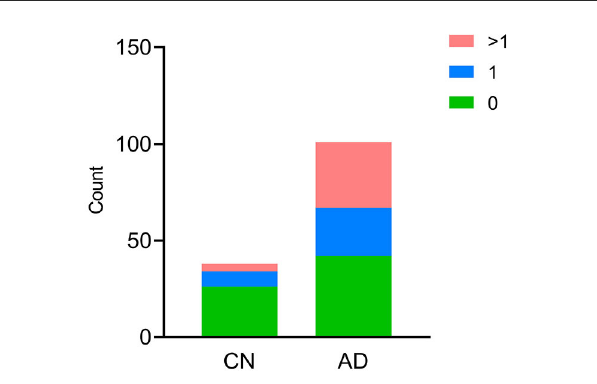
FIGURE1 Cerebral small-vessel disease (CSVD) burden in CN and AD individuals. The number of participants with different CSVD burdens is shown, green bar CSVD burden = 0, blue bar CSVD burden = 1, red bar CSVD burden > 1.